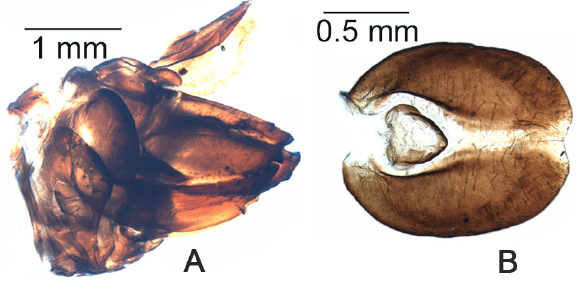
Fig. 10. Atracis sphaerica sp. nov. A . Female terminalia, right lateral view. B . Anal segment, dorsal